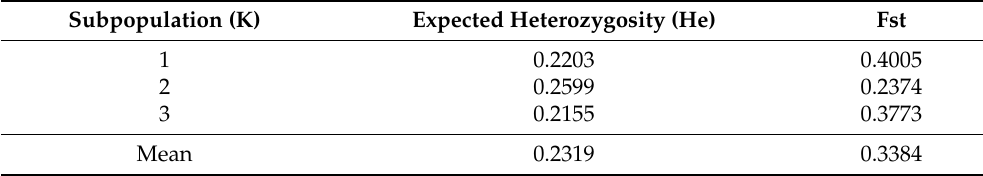
Table 8. Expected heterozygosity (He) and Fst values in three wheat